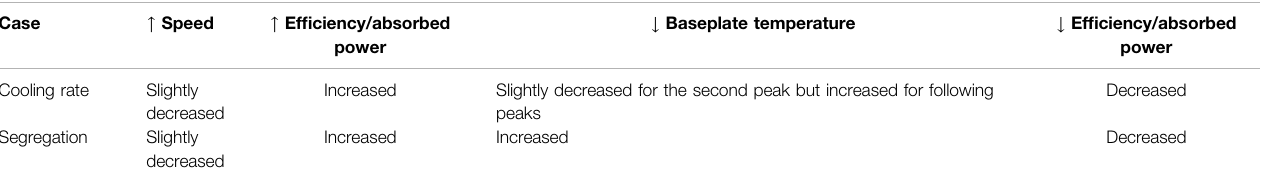
TABLE 5 | Summary of parameter effects on cooling rate and segregations.